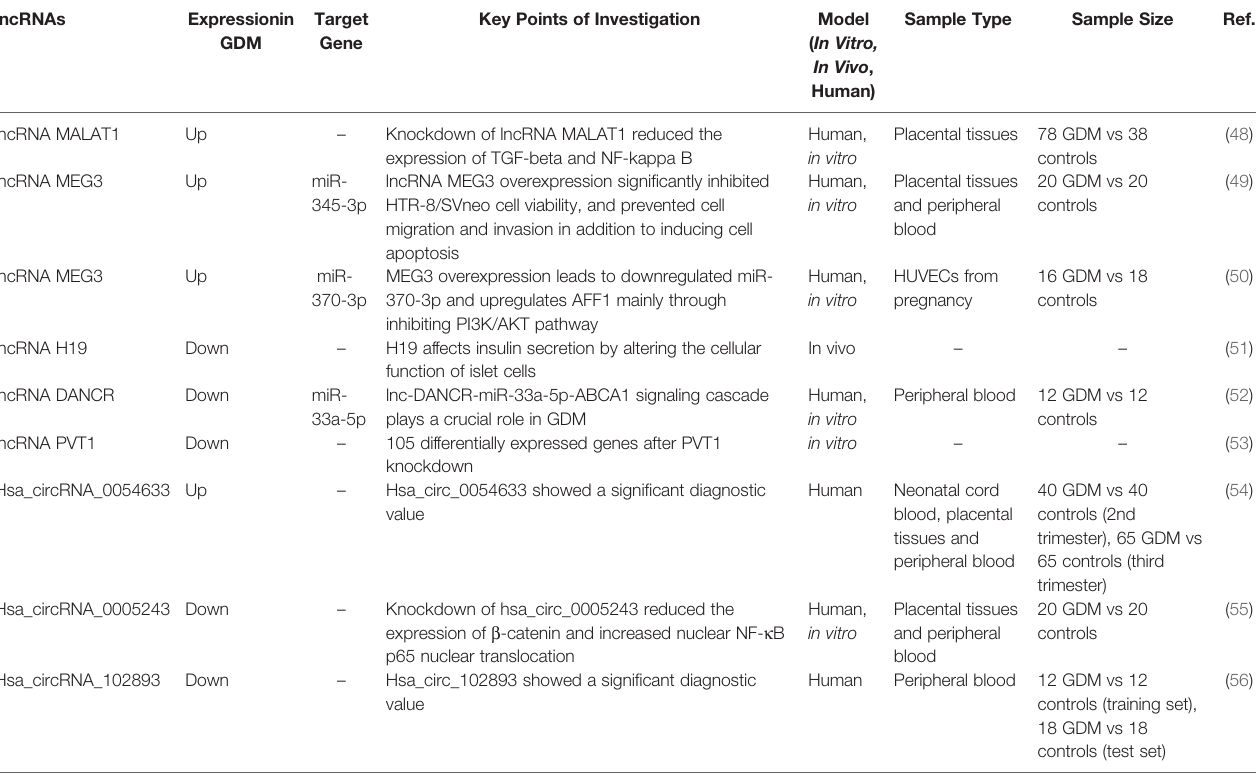
TABLE 1 | Selected lncRNAs and circRNA involved in